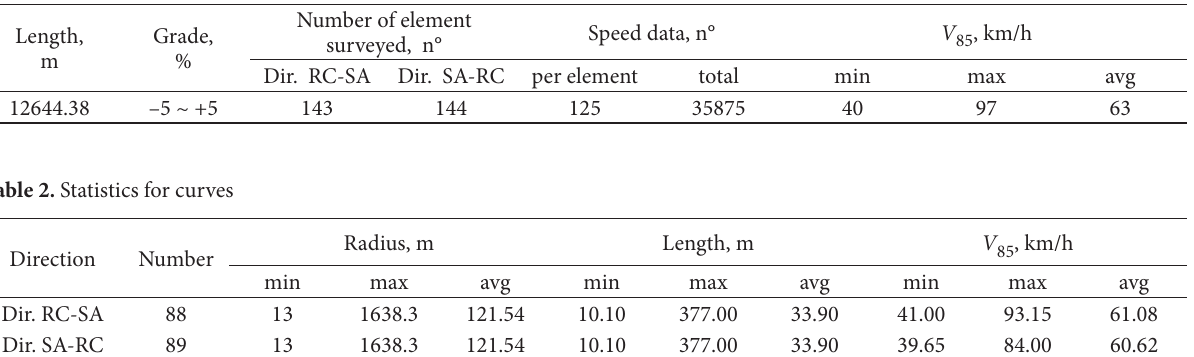
Table 1. General data of SS 18 under investigation